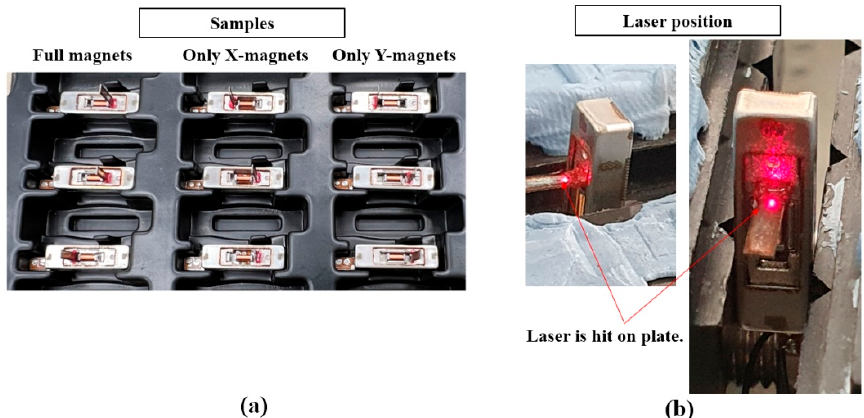
Figure 15. Samples for total stiffness testing: ( a ) samples with different magnet settings and ( b ) laser position.